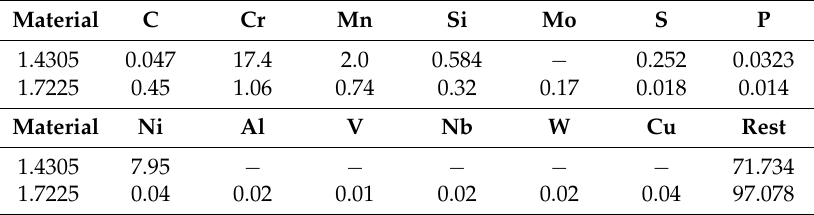
Table 1. Chemical composition of considered materials